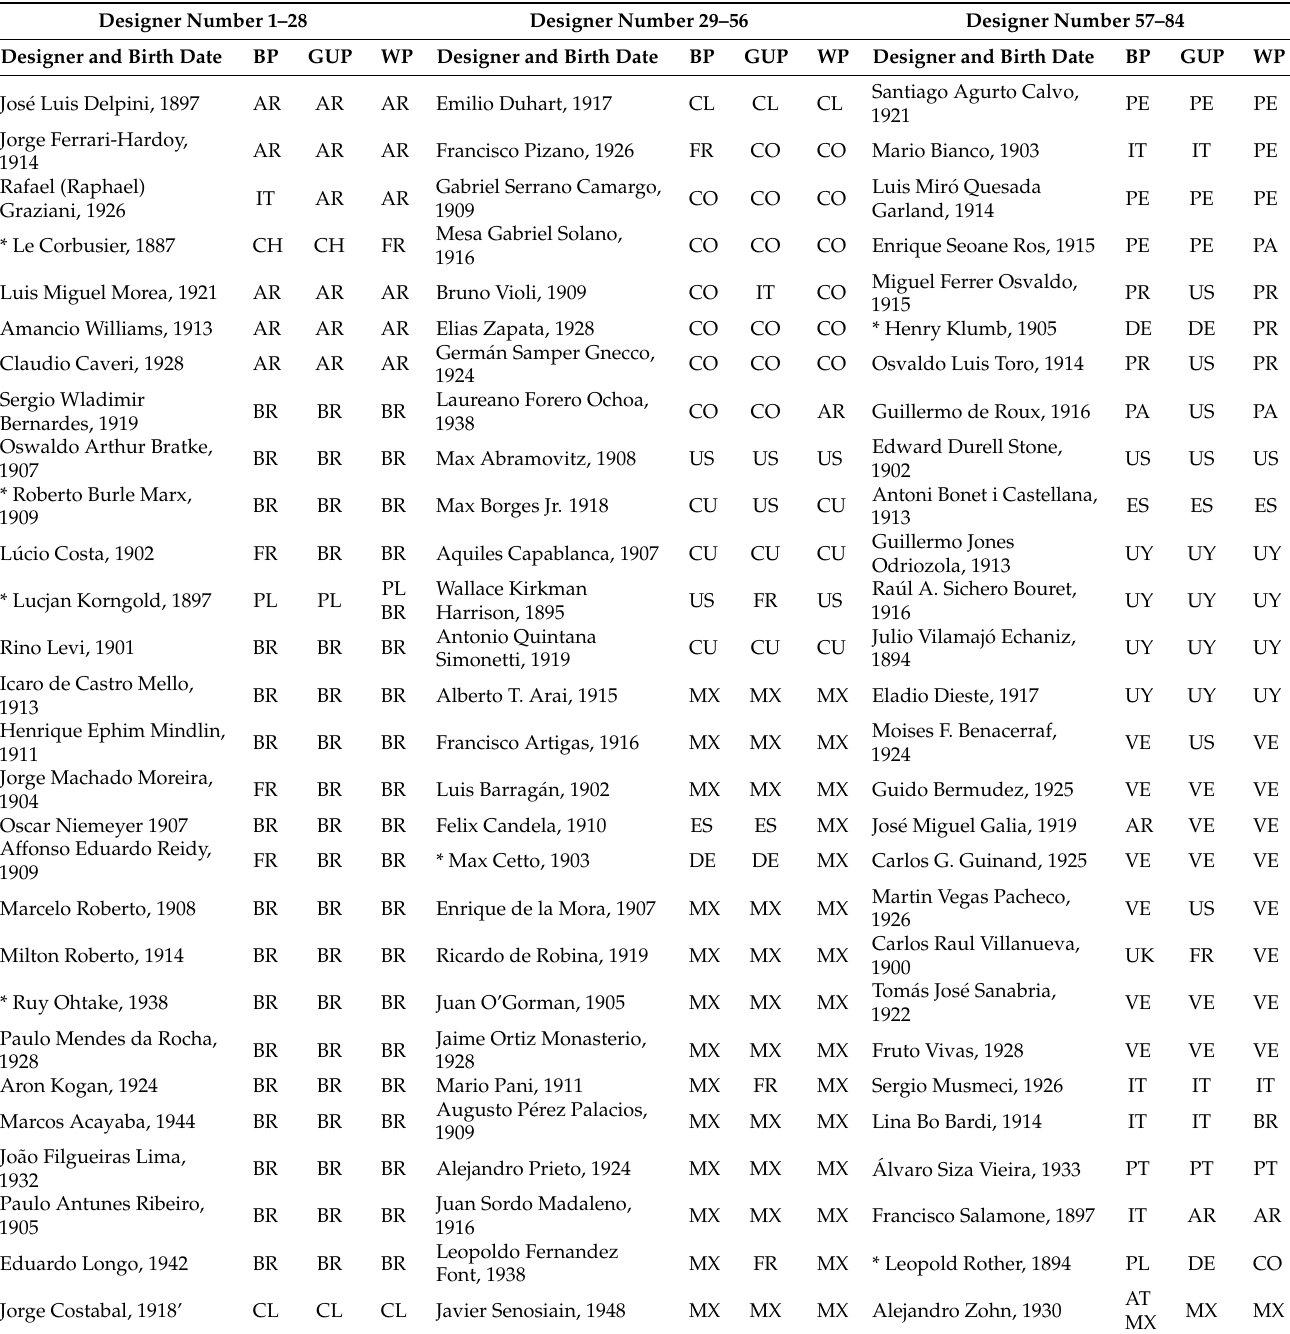
Table 1. The list of the designers and the summaries of their